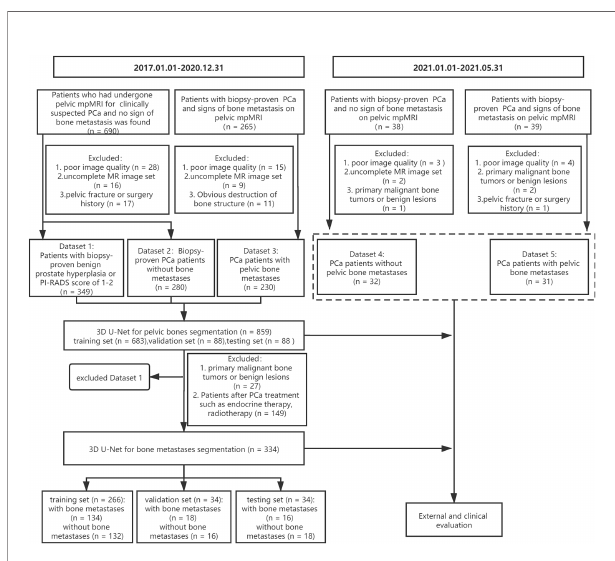
FIGURE 1 | The work fl ow of data